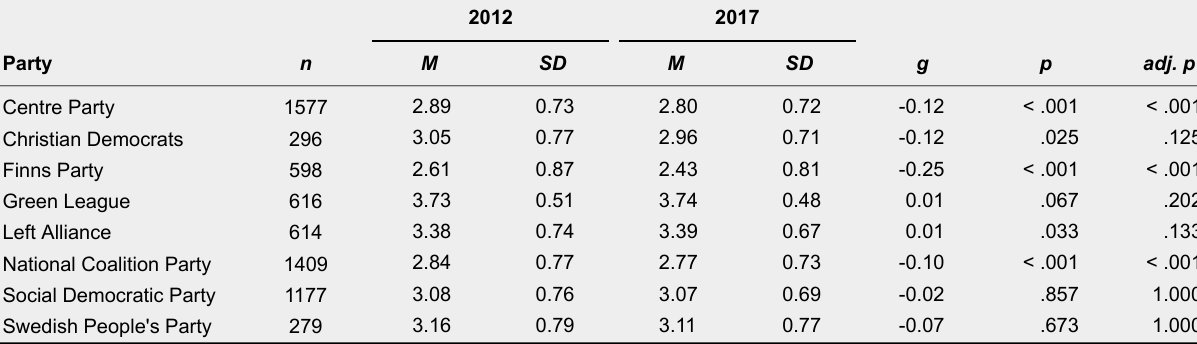
Party-Specific Descriptive Statistics and Standardized Mean Differences in Preservation of the Natural Environment